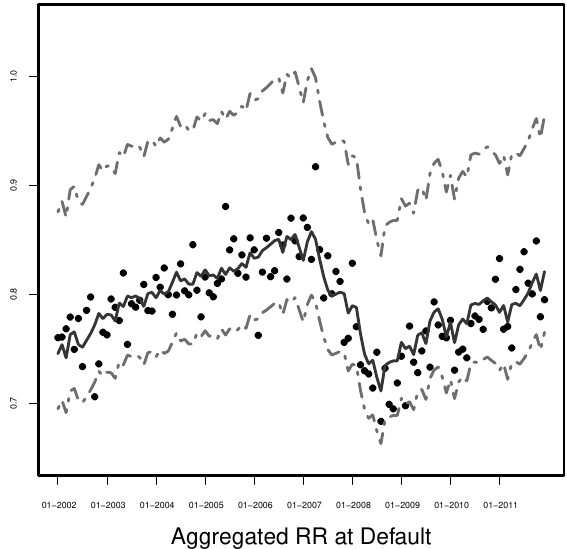
Figure 12. Monthly aggregated recovery rates with 99% prediction interval (grey dot-dash line) and the mean of the predictions (grey solid line) at the time of default for Model